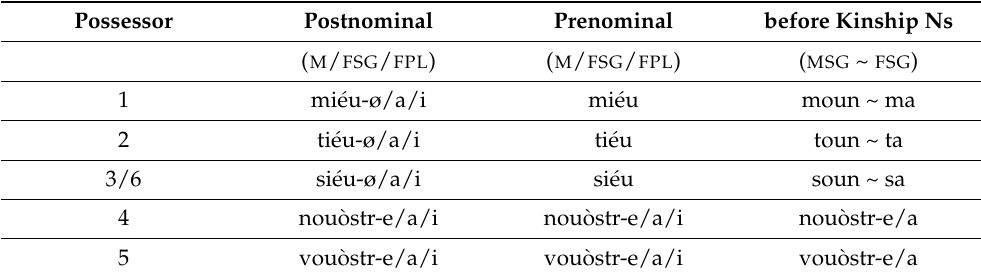
Table 4. Paradigm of Nissart possessives.